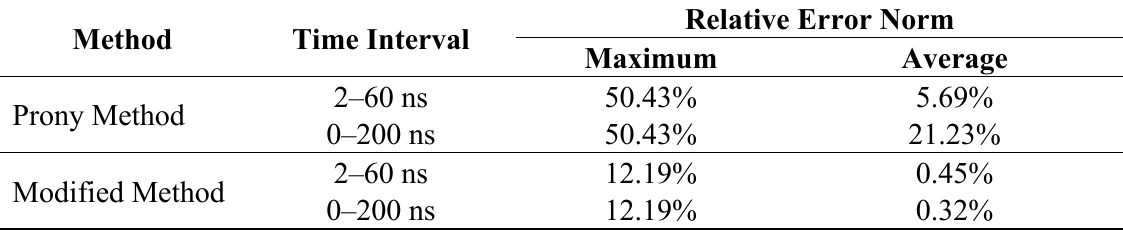
Table 2. Relative error between the impulse response given by each method and the IEC 61000-4-2 equation for the ESD